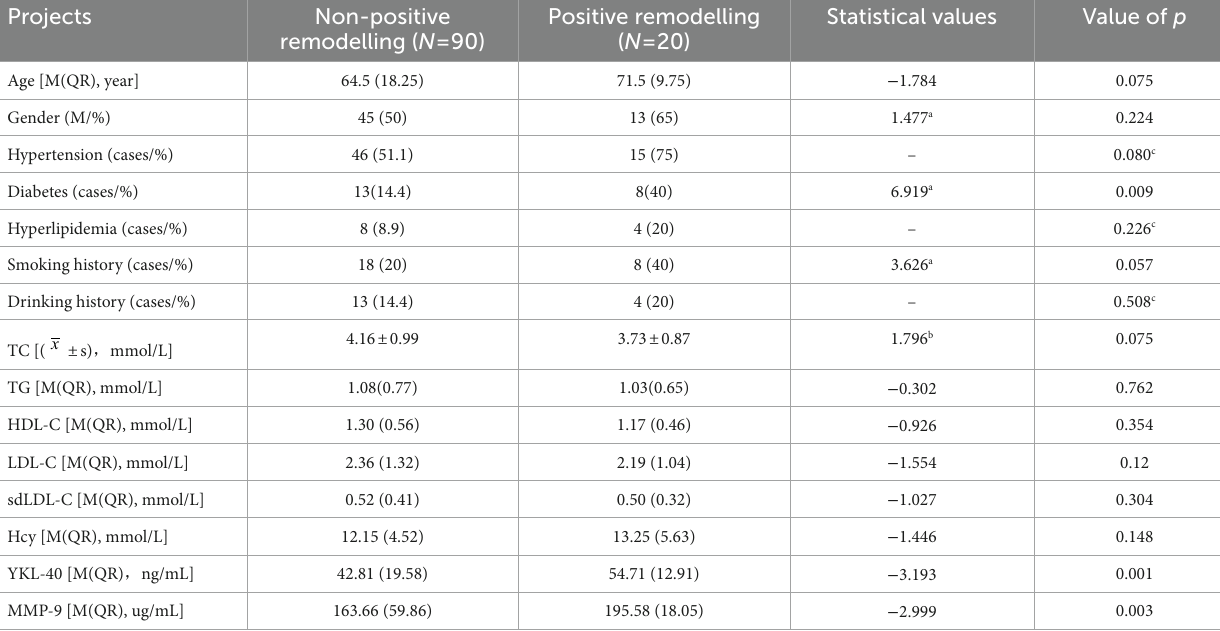
TABLE 4 Comparison of posterior circulation positive and non-positive remodeling in the posterior circulation. Projects